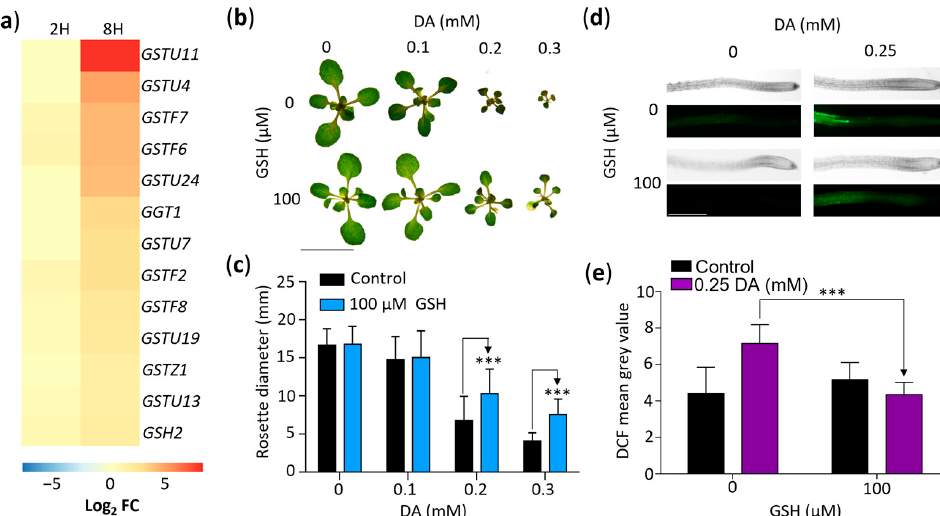
Figure 6. Glutathione (GSH) suppresses DA-induced growth inhibition and ROS accumulation. ( a ) DA upregulates the expression of genes encoding GSH transferases. Gene-level expression data were generated as described in the Materials and Methods. GSH-associated DEGs were extracted and are presented as a heatmap of log2 fold changes (Log2 FC) at 2 (2H) and 8 (8H) hours. All presented DEGs with a non-zero log2 FC have an FDR < 0.0001. ( b ) GSH supplementation attenuates DA-induced inhibition of rosette growth. Col-0 was grown for 14 days on MS/2 media supplemented with the denoted concentrations of DA and GSH. ( c ) Quantitative analysis of the impact of GSH supplementation on DA-induced rosette growth inhibition. Plants were grown as described in ( b ) and were photographed, and rosette diameter was measured using ImageJ software. Data are presented as mean ± SD ( n ≥ 20; *** represents p < 0.001; one-way ANOVA with Tukey’s post-test; multiple comparisons are demarked by one-way arrows). ( d ) GSH attenuates DA-induced ROS accumulation in roots. Col-0 seedlings grown for 7 days on MS/2 media supplemented with the denoted concentrations of DA and GSH were submerged in 10 µM H2DCF-DA and were incubated at room temperature in complete darkness for 15 min. DCF was visualized using fluorescent microscopy. Scale: 0.5 mm. ( e ) Quantitative analysis of the micrographs described in ( d ). Mean grey value (MGV) of DCF fluorescence was measured 1.5 mm from root cap. Data are presented at mean ± SD ( n ≥ 9; *** represents p < 0.001; one-way ANOVA with Tukey’s post-test; comparisons are demarked by one-way arrows).